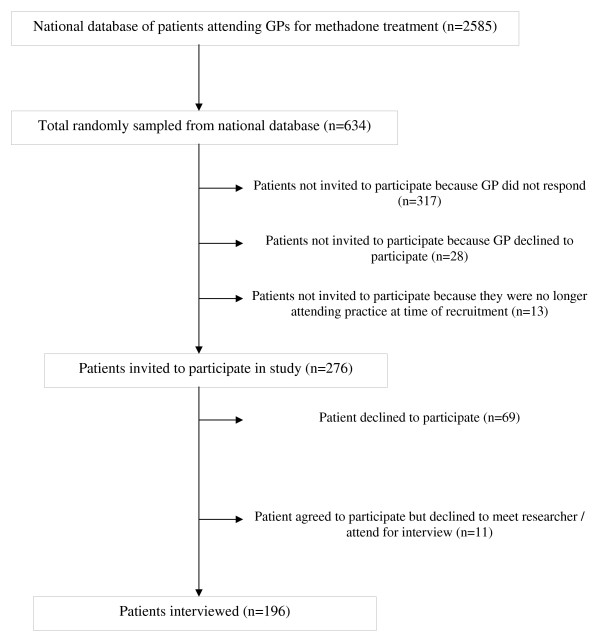
Patient recruitment.